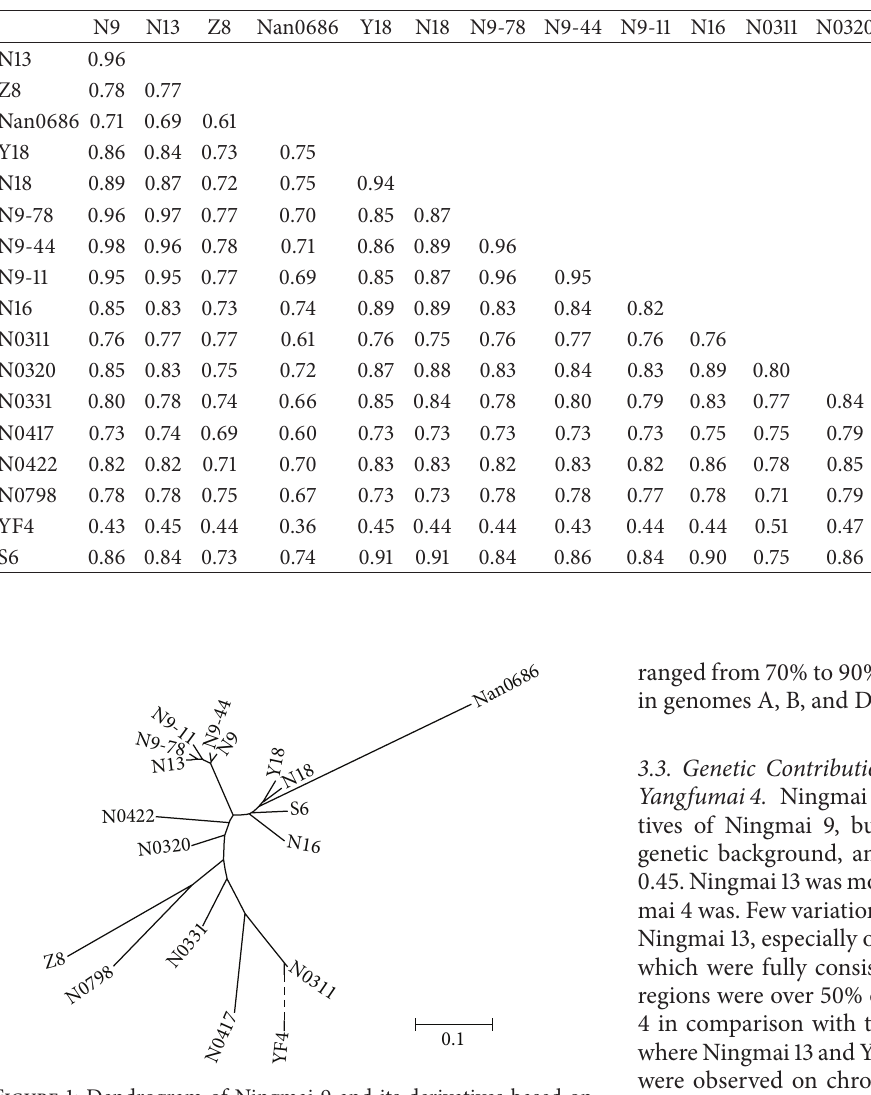
Table 2: Genetic similarity coefficient among N9 and its derivatives.